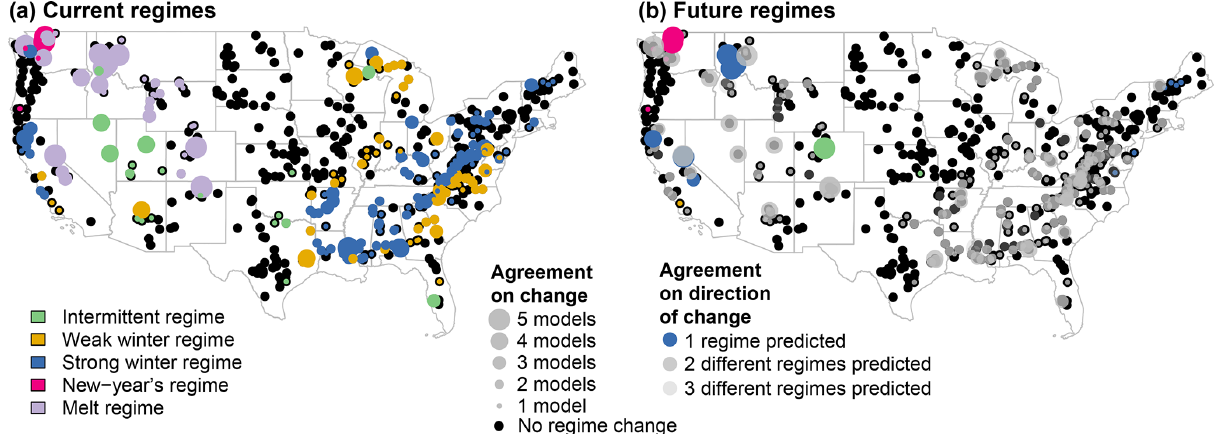
Figure 7. (a) Current regimes and agreement of models regarding regime changes. Catchments colored according to their observed regime show catchments where at least one out of the five GCMs predicts a regime class change. The size of the dot indicates the strength of model agreement. (b) Future regimes and agreement of models regarding the direction of change. The size of the dot indicates agreement on change, the color of the dot the agreement on direction of change. All GCMs predict the same change in colored catchments; GCMs disagree on the direction of change in grey catchments, where the shading indicates the strength of agreement. Black catchments are either predicted to experience no changes or their reference regime was incorrectly predicted by more than two